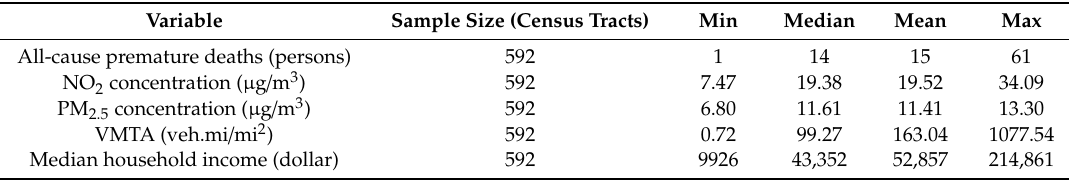
Table 1. Summary statistics of input